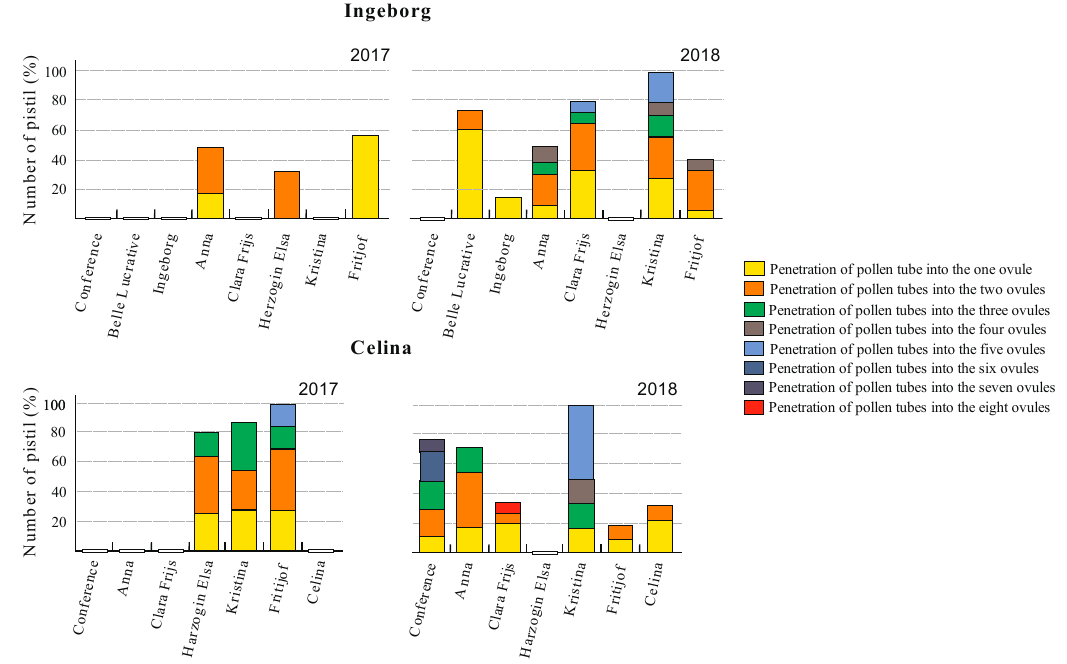
Figure 8. Number of pistils with different numbers of fertilized ovules (12th DAP) of the pear cultivars “Ingeborg” and “Celina” in different combinations of pollination in 2017 and 2018. For “Celina”, the highest percentage of pistils with fertilized ovules was recorded when “Fritjof” (100%) and “Kristina” (82.5%) were pollinizers in 2017. In contrast to the first year of study, the percentage of pistils with the highest number of fertilized ovules was recorded in “Celina” × “Kristina” (100%) and “Celina” × “Conference” (80%).